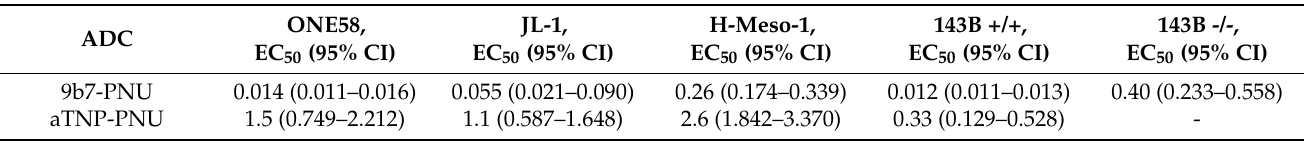
Table 1. EC 50 values for cells cultured with 9b7 or aTNP-PNU ADCs. CI, confidence interval; EC 50 , the concentration required to achieve a 50% reduction of cell viability ( µ g/mL).